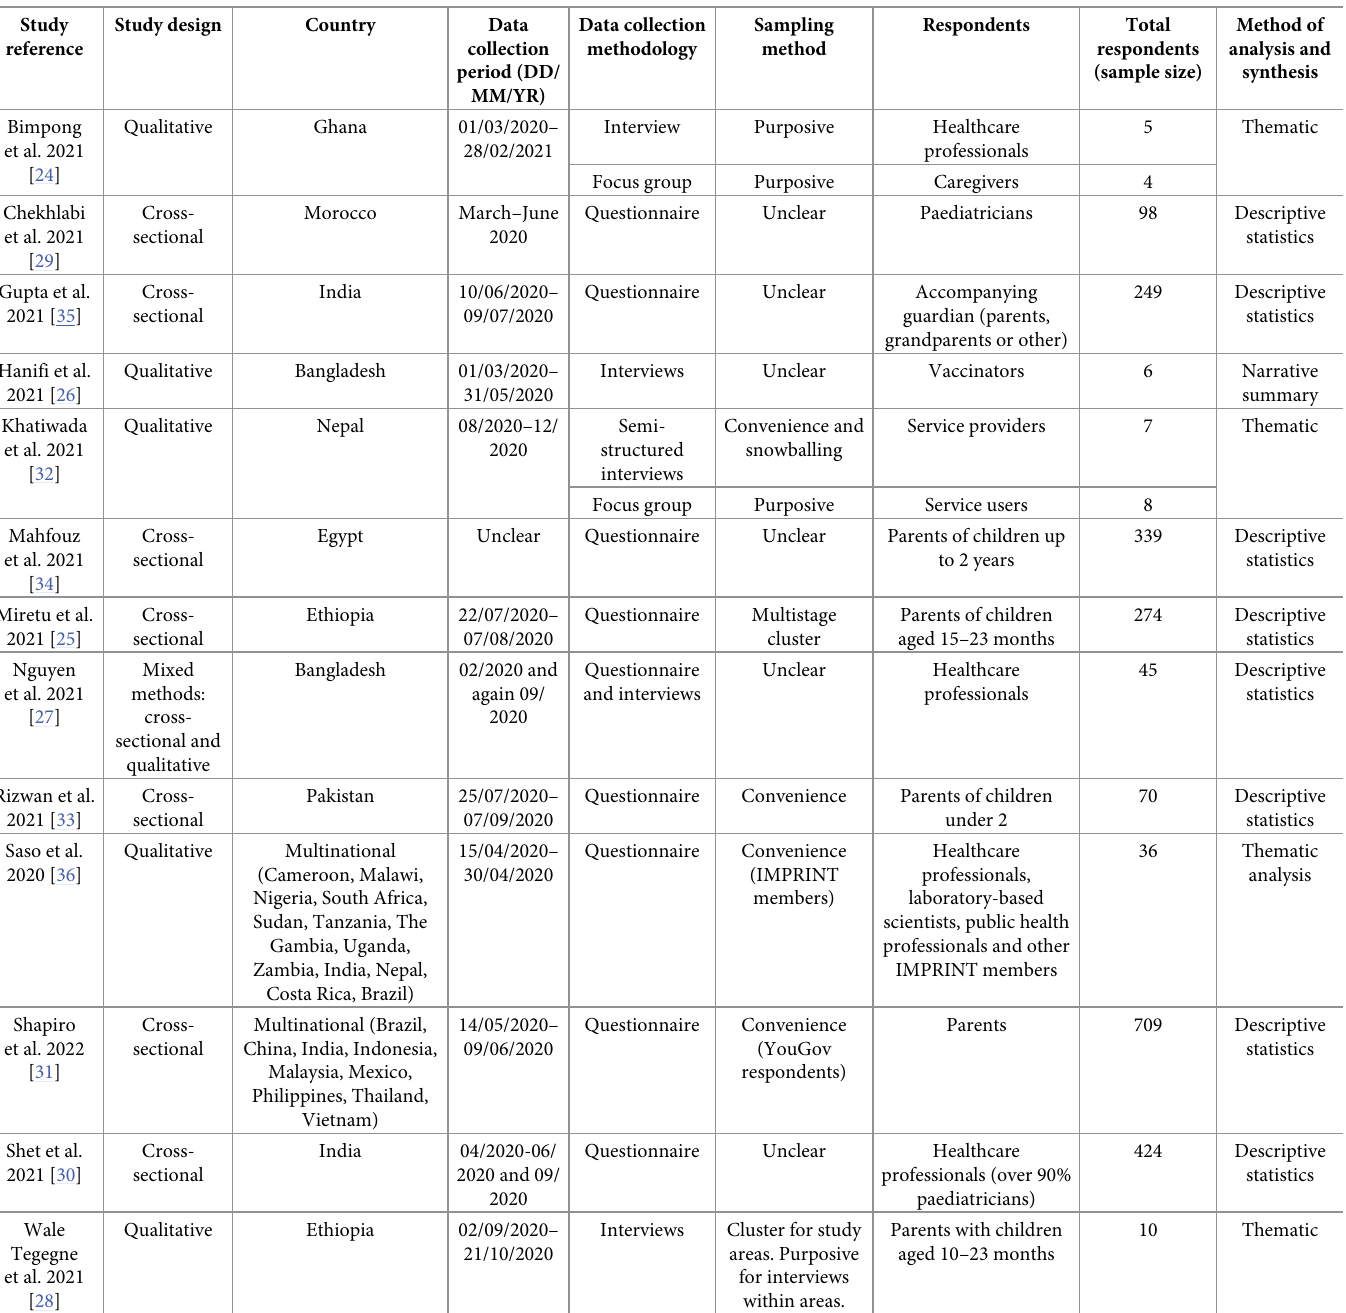
Table 3. Characteristics of each included